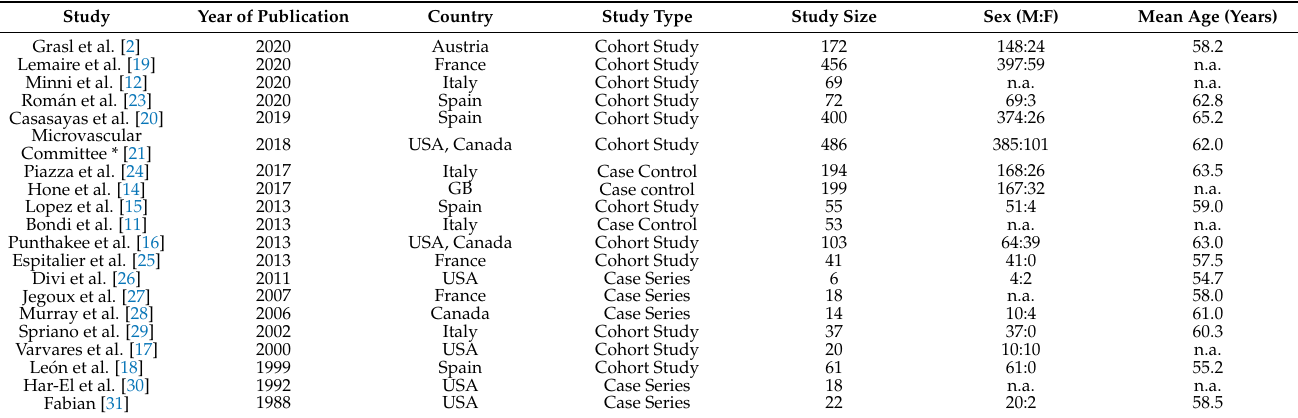
Table 1. Characteristics of the included